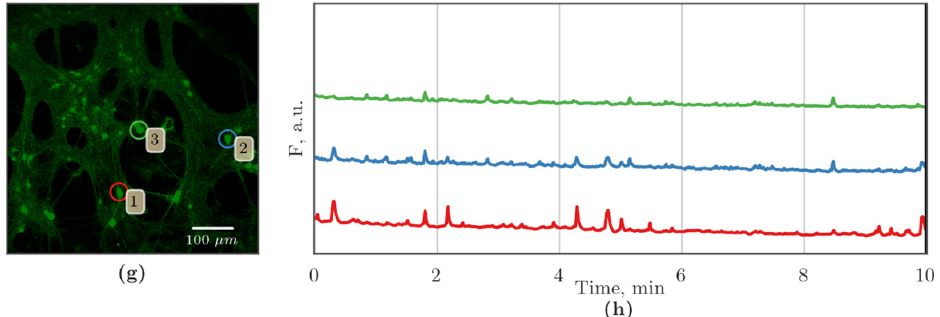
Figure 3. Representative recordings of spontaneous calcium activity of cells in primary cortical cultures on the third day of the post-hypoxic period: ( a , b ) Sham; ( c , d ) Gap19; ( e , f ) Hypoxia; ( g , h ) Hypoxia+Gap19. Scale bars: 100 µ m.